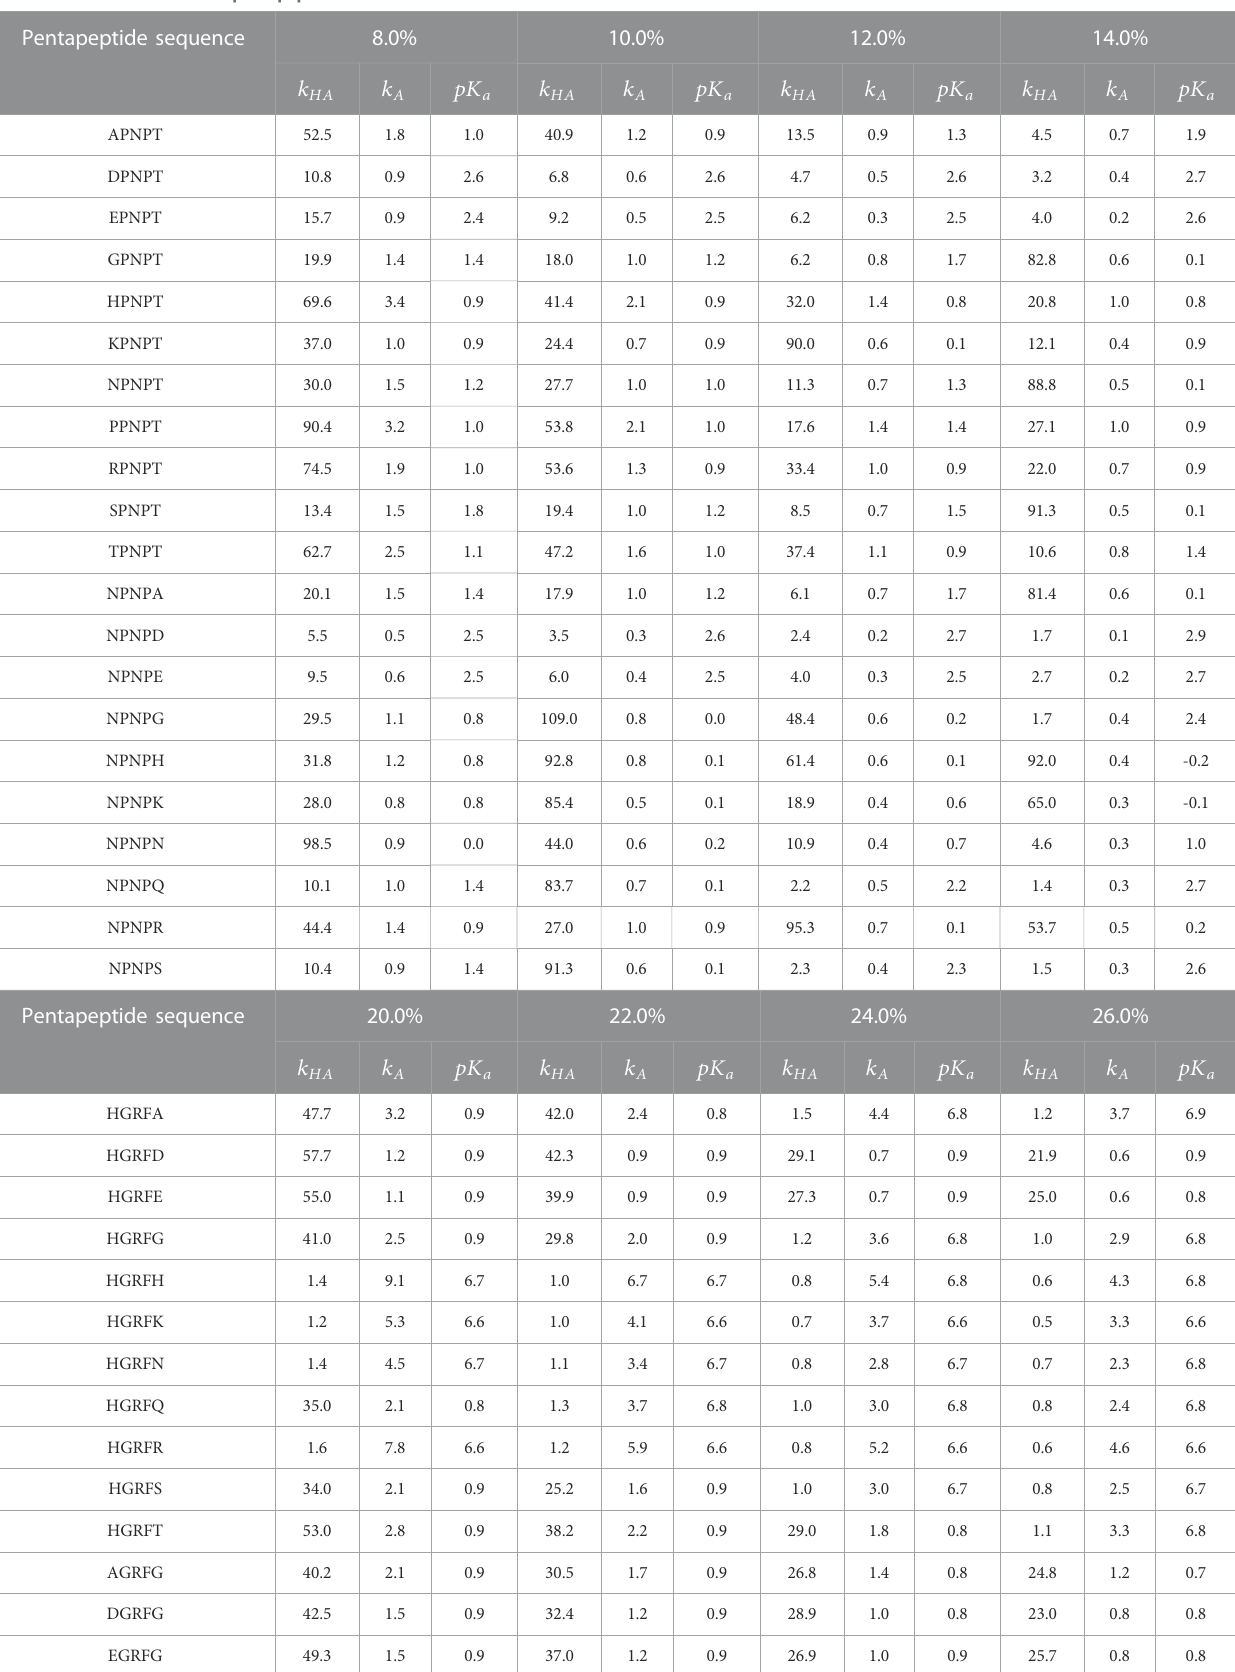
TABLE 2 Parameter results of pentapeptides at 25 ° C. Pentapeptide